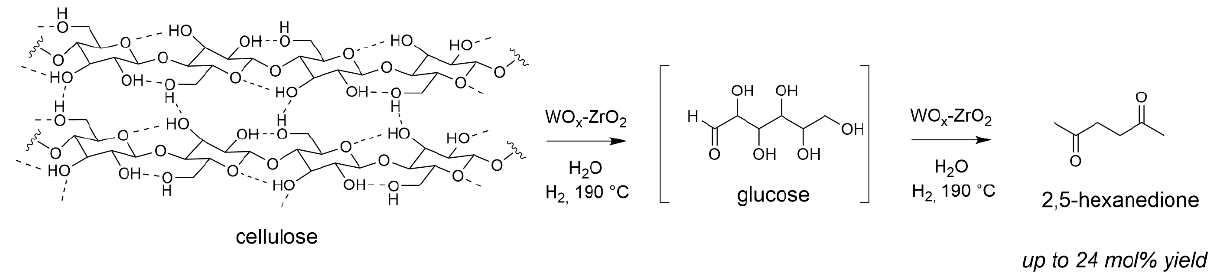
Scheme 4. Formation of 2,5-hexanedione from cellulose in the presence of solid Lewis acid (water 65 mL, Avicel cellulose